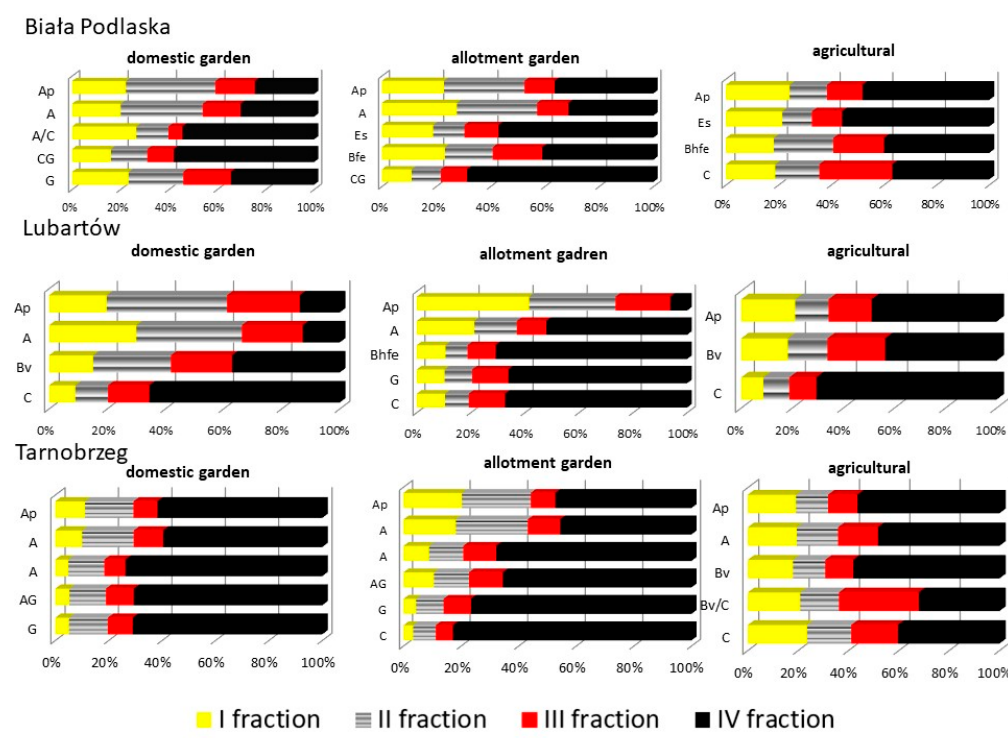
Figure 2. Percentage content of Zn fractions in sandy soils.